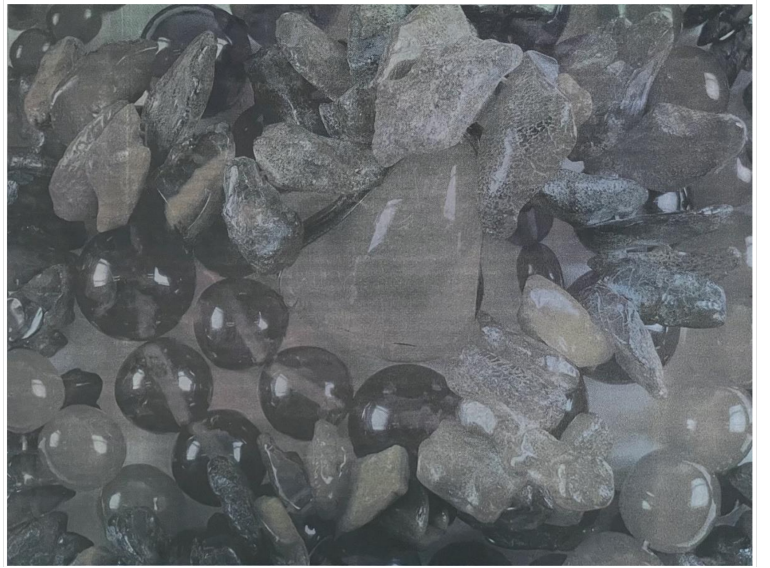
Figure A7. 25LPI, offset litho, Spectraval™ pigments, R = 2 × pass, G = 3 × pass, B = 2 × pass, black Plike, film negative, print size: 600 mm × 450